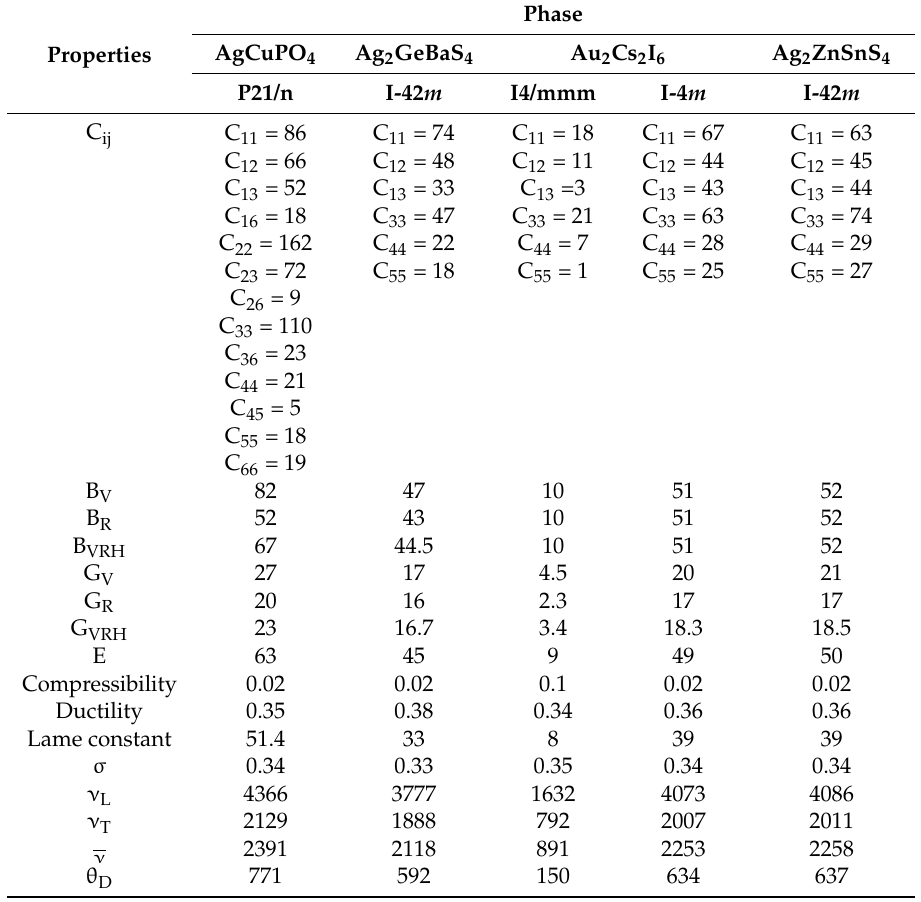
Table 3. The calculated single-crystal elastic constants C ij (in GPa), bulk modulus B (in GPa), shear modulus G (in GPa), Poisson’s ratio ( σ ), Young’s modulus E (in GPa), compressibility (GPa − 1 ), ductility, Lame constant, longitudinal ( ν L ; in m/s), transverse ( ν T ; in m/s), average sound velocity ( ν , in m/s), and Debye temperature ( θ D ) for AgCuPO 4 , Ag 2 GeBaS 4 , Au 2 Cs 2 I 6 , and Ag 2 ZnSnS 4 phases. Subscript V indicates the Voigt bound, R indicates the Reuss bound, and VRH indicates the Hill